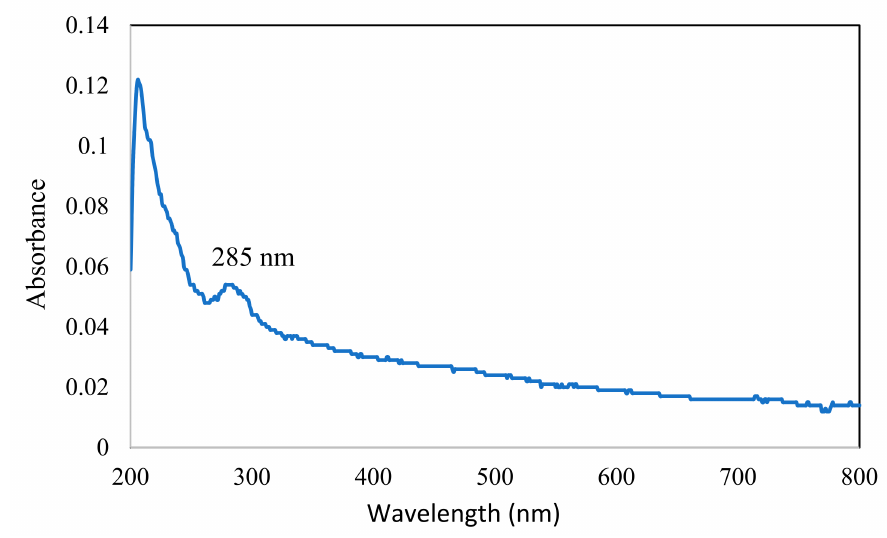
Figure 1. UV-visible spectra of cinnamon essential